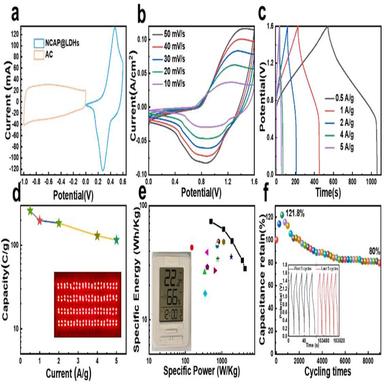
The electrochemical behavior of HSC. The CV response of NCAP@LDHs and AC under the different potential window (a), the CV response (b), galvanostatic charge-discharge (GCD) curves (c) of HSC, the specific capacity of HSC (d), the comparison of specific power and specific energy with other works (e), the cyclic performance of HSC (f).